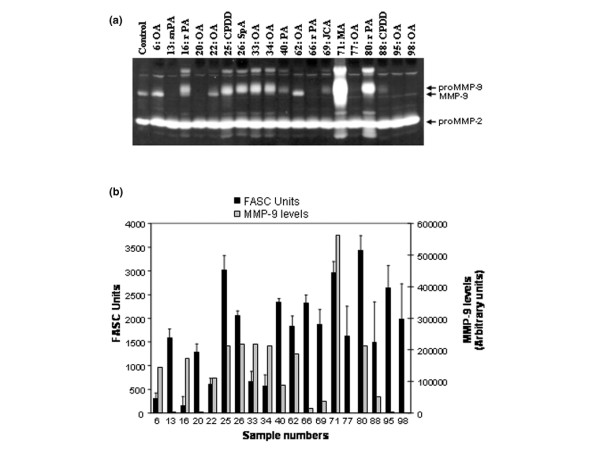
Zymographic analysis of MMP-2 and MMP-9 levels in arthritic synovial fluids. (a) Secretion of MMP-2 and MMP-9 was assessed by gelatin zymography using standard procedures. Aliquots of 10 μl synovial fluids (SF) (diluted 1:10) were loaded into each lane. OA, osteoarthritis; snPA, seronegative polyarthritis; rPA, seropositive rheumatoid polyarthritis; CPDD, calcium phosphate deposition disease; SpA, spondyloarthropathy; PA, polyarthritis; JCA, juvenile chronic arthritis; MA, microcrystalline arthritis. (b) Semiquantitative measures of the proMMP-9 level were carried out by densitometric analysis (scored as arbitrary units) and compared with the net proteolytic activity (NPA) found in the same SF. No correlations between the NPA and the level of the 225 kDa form of MMP-9 or with that of its active form (92 kDa) were observed (data not shown). FASC, fluorescent-activated substrate conversion. As a positive control, an aliquot of supernatant of HT1080 cell culture containing both MMP2 and MMP-9 gelatinases was used. The results were obtained using duplicates and are representative of two independent experiments. Error bars represent the mean ± standard error of the mean.